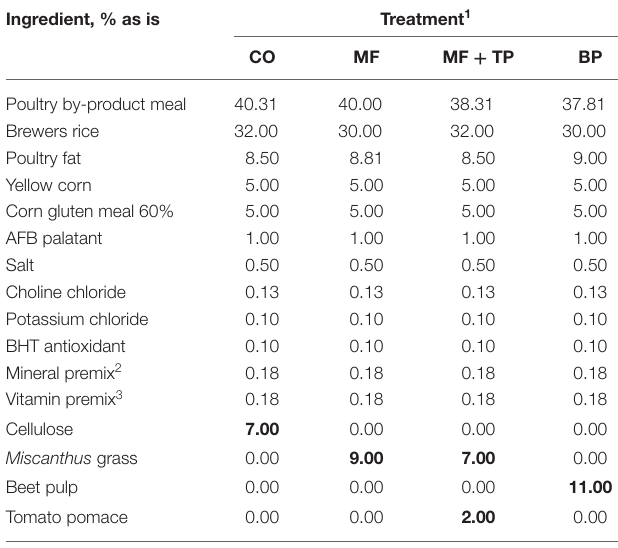
TABLE 1 | Ingredient composition of treatments containing traditional and novel fiber sources for adult felines. Ingredient, % as